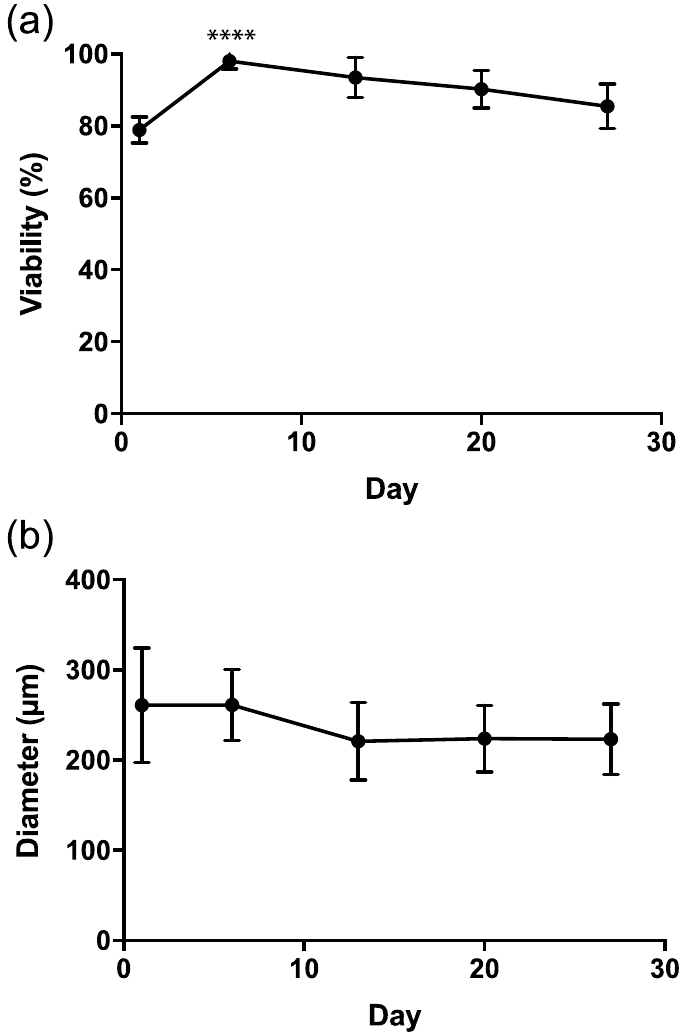
Figure 4. Viability and diameter size of the encapsulated murine granulosa and theca cells over prolonged culture. The figures represent data from four separate experiments. ( a ) viability of encapsulated murine granulosa and theca cells; ( b ) diameter of capsule.